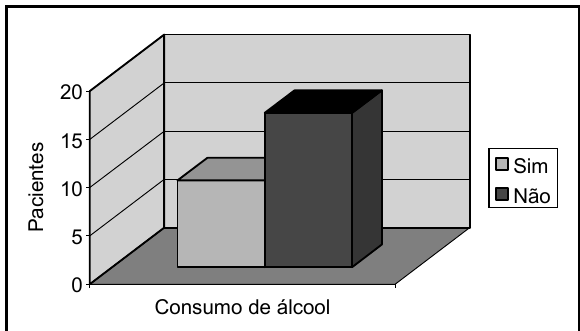
Figura 6 – Distribuição dos pacientes em relação ao consumo de álcool